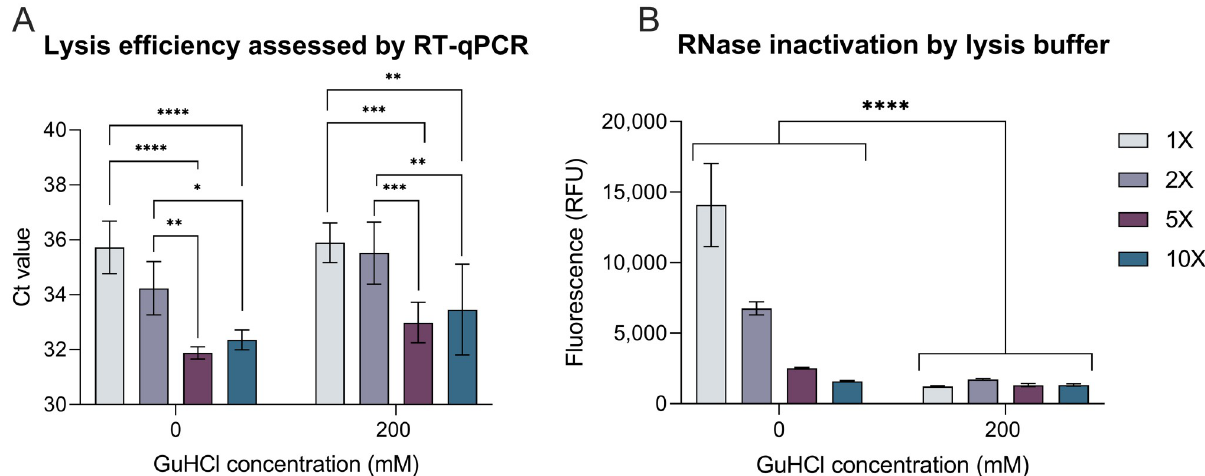
Fig 2. Lysis buffer evaluation and optimization. Four lysis buffer concentrations (1X, 2X, 5X, and 10X) with and without 200 mM GuHCl were evaluated. Candidate buffers were combined with negative nasal swab eluate, spiked with Zeptometrix pseudovirus and heated at 95˚ C for 5 minutes. (A) Average Ct values resulting from lysed samples amplified in the CDC N1 RT-qPCR assay following column purification ( ± standard deviation; n = 6 for each condition). Significance determined using a two-way ANOVA with post-hoc Tukey’s test. (B) Average relative fluorescence values from lysed samples at the 1-hour timepoint of an RNase Alert assay ( ± standard deviation; n = 3 for each condition). Significance determined using two-way ANOVA. ���� indicates p < 0.0001, �� indicates p < 0.01, � indicates p < 0.05.